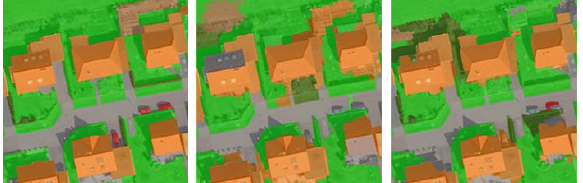
Figure 4: Pixel-wise ground truth (left), classification result of the two-layer CRF approach based on superpixels of size 50 x 50 (centre) and of size 20 x 20 (right). Colours: build. (red), seal. (grey), soil (brown), grass (green), tree (dark green), car (red), others (pink).